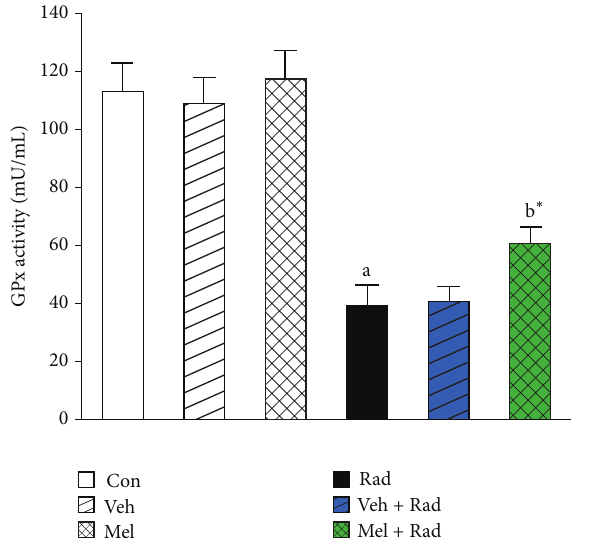
Figure 6: The effect of melatonin on GPx activity in rats subjected Figure 8: The effect of melatonin on TAC levels in rats subjected to whole body gamma irradiation. Data represent mean ± standard to whole body gamma irradiation. Data represent mean ± standard error on the mean (SEM) for 5 animals per group. Con: Control error on the mean (SEM) for 5 animals per group. Con: Control group, Veh: Vehicle only group, Mel: Melatonin only group, Rad: group, Veh: Vehicle only group, Mel: Melatonin only group, Rad: Radiation only group, Veh + Rad: Treated with vehicle and exposed Radiation only group, Veh + Rad: Treated with vehicle and exposed to10Gyradiation,andMel+Rad:Treatedwith100 mg/kgmelatonin to10 Gyradiation,andMel+Rad:Treatedwith100 mg/kgmelatonin before exposure to 10Gy radiation. a 𝑃 < 0.001 when compared to before exposure to 10 Gy radiation. a 𝑃 < 0.001 when compared to ∗ 𝑃 < 0.01 Control group. b 𝑃 < 0.001 when compared to the Radiation only when compared to the Radiation only Control group. b group.